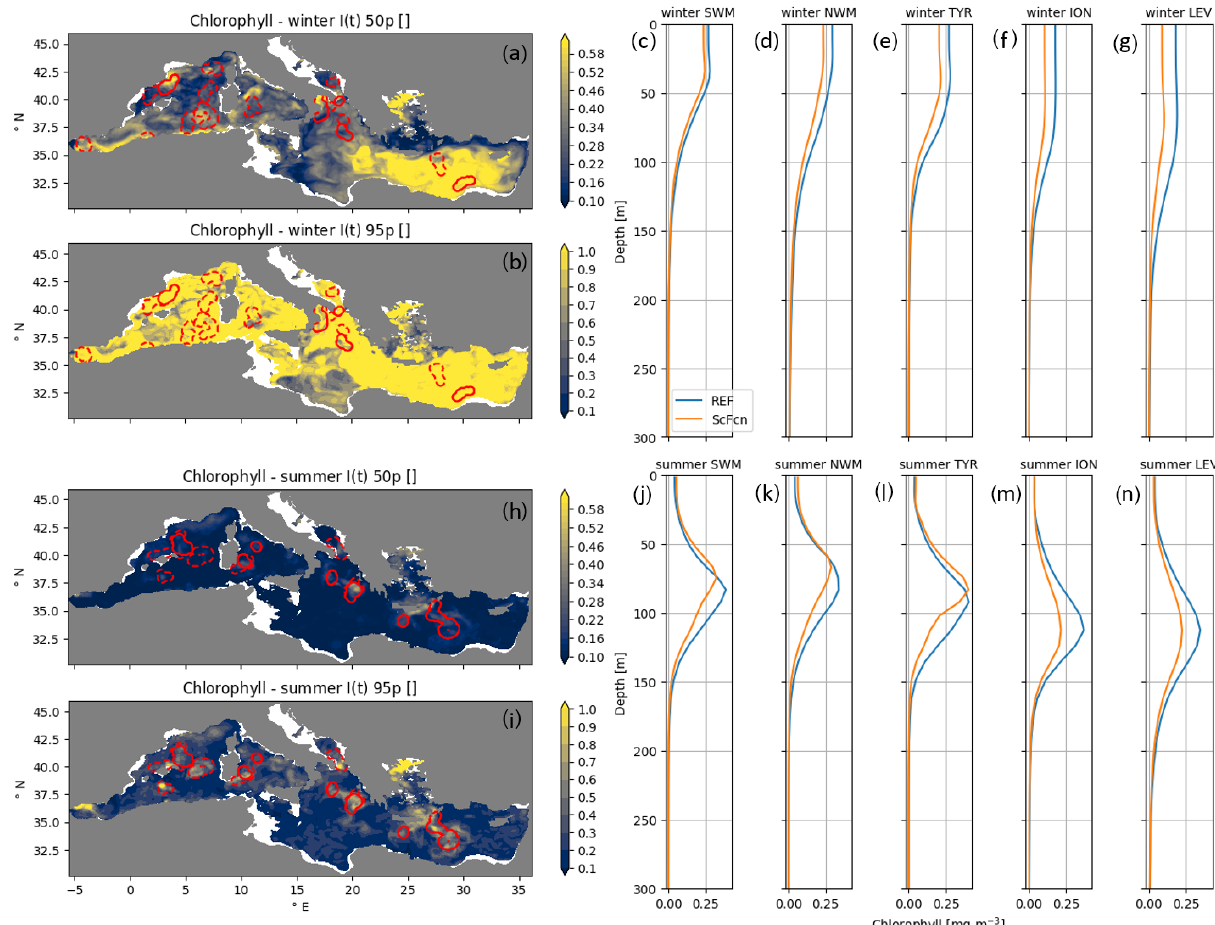
Figure 6. Maps of I xy (t) 50th and 95th percentiles for chlorophyll in winter and summer (a, b, h , and i) ; red contours identify the areas within three correlation radii from the float positions (dashed lines for floats without nitrate observations). Mean profiles at time and location with I xy (t) higher than 0.3 in five sub-basins for the ScFcn and REF simulations (c, d, e, f, g, j, k, l, m , and n) in winter (c–g) and summer (j–n)